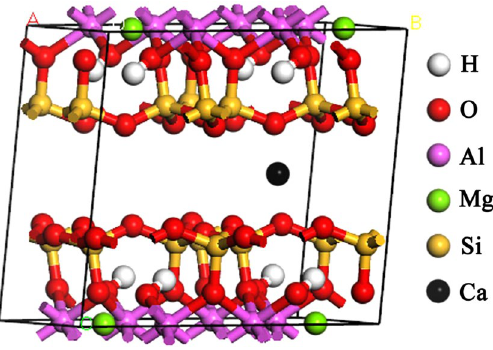
Figure 1. The structure of the